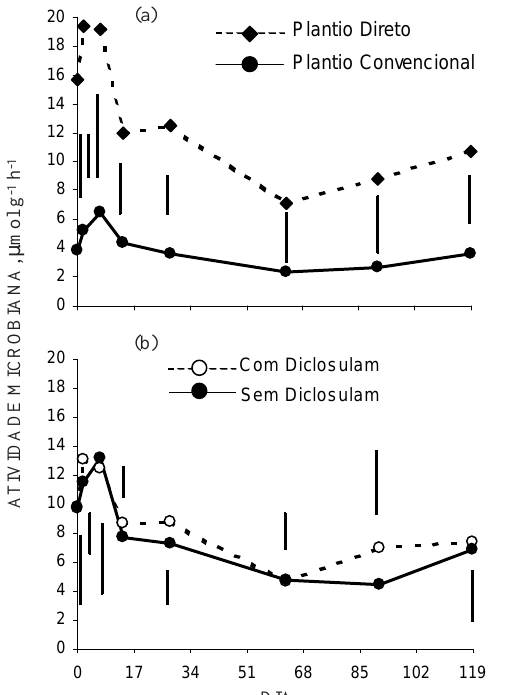
Figura 3. Atividade microbiana num Latossolo Vermelho distroférrico cultivado há 10 anos sob (a) plantio direto ou convencional e (b) com e sem aplicação de diclosulam. As barras verticais indicam a diferença mínima significa- tiva (DMS) pelo teste t a